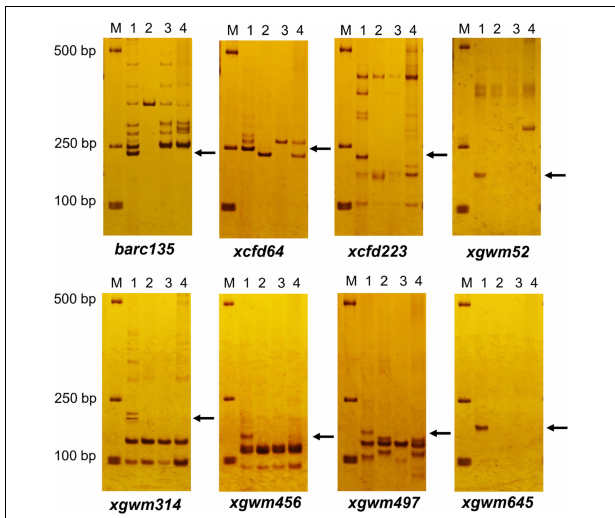
FIGURE 3 | Simple sequence repeat (SSR) markers analysis to genotypes DH109 and DM131. Among 206 pairs of SSR markers, eight pairs of markers comprising barc135 , xcfd64 , xcfd223 , xgwm52 , xgwm314 , xgwm456 , xgwm497 , and xgwm645 on the wheat 3D chromosomes did not amplify 3D genome–specific bands in durum wheat Trs-372, DH109, and DM131. Lane M, DL2000 marker; lane 1, common wheat 7182; lane 2, Trs-372; lane 3, DH109; lane 4, DM131. Arrows indicate the missing D genome–specific bands.